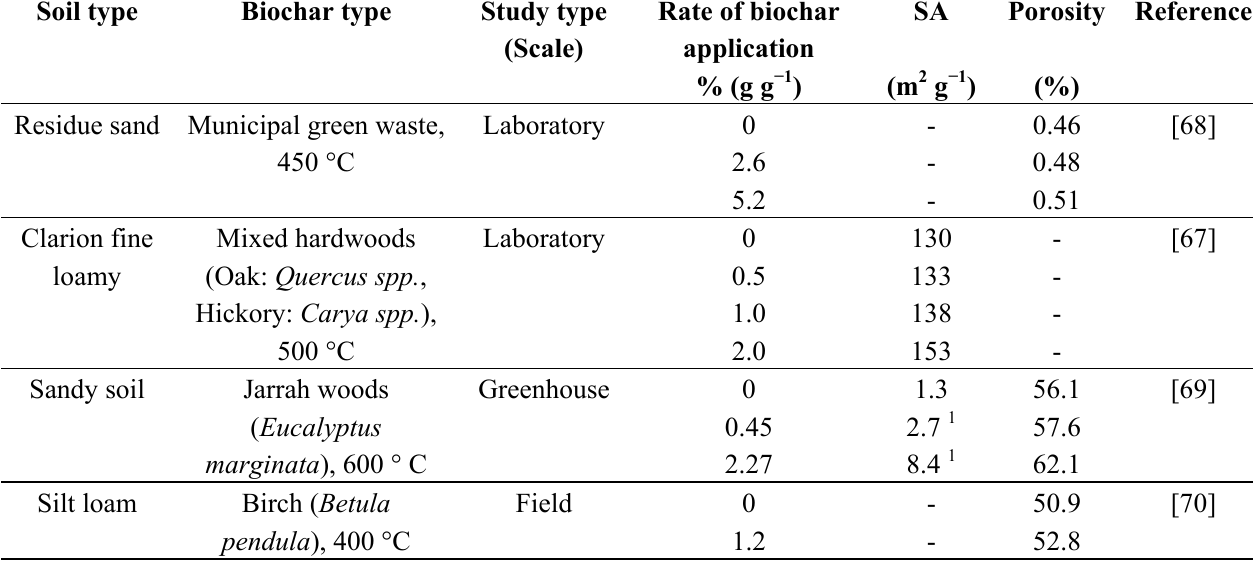
Table 1. Impact of biochar on surface area and porosity of amended soils (Rate of 0 represents control or unamended